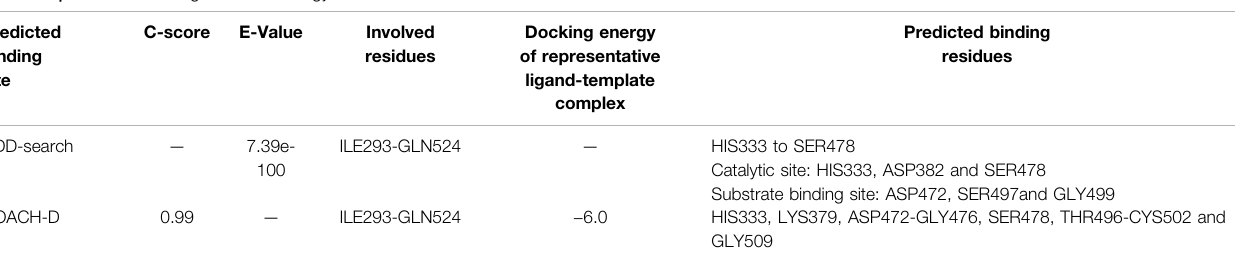
TABLE 2 | Predicted binding site of homology model of TMPRSS2.